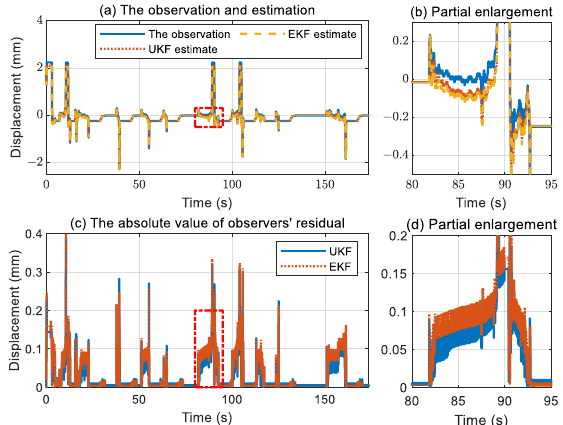
Figure 18. The measurement and its residual in the vehicle